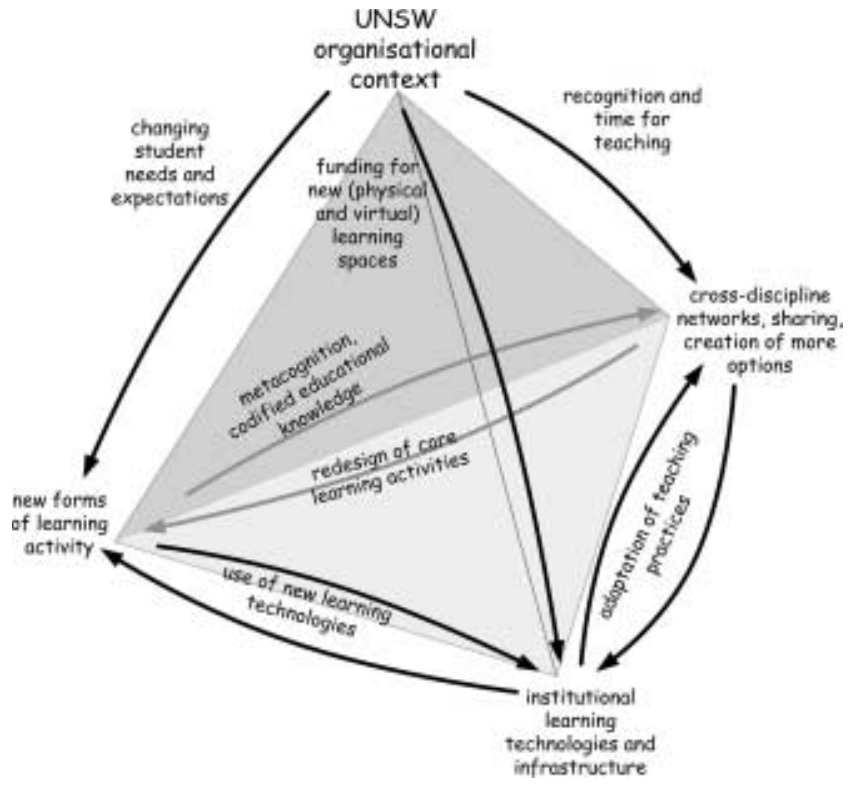
Figure 5. Model of the changing UNSW learning and teaching